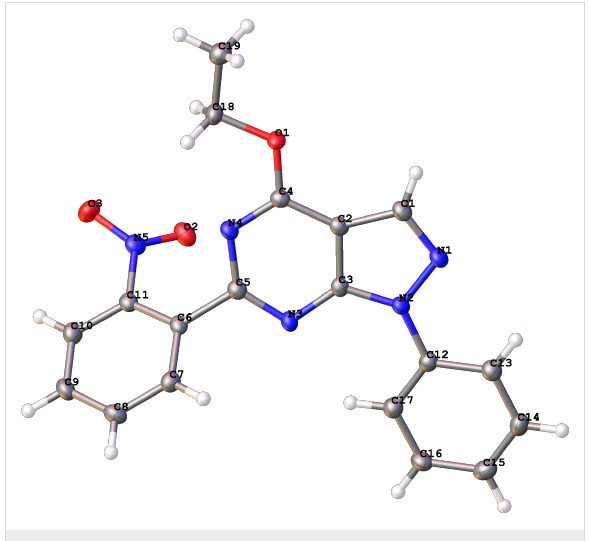
Figure 2: Molecular structure (from X-ray diffraction data) of 5g